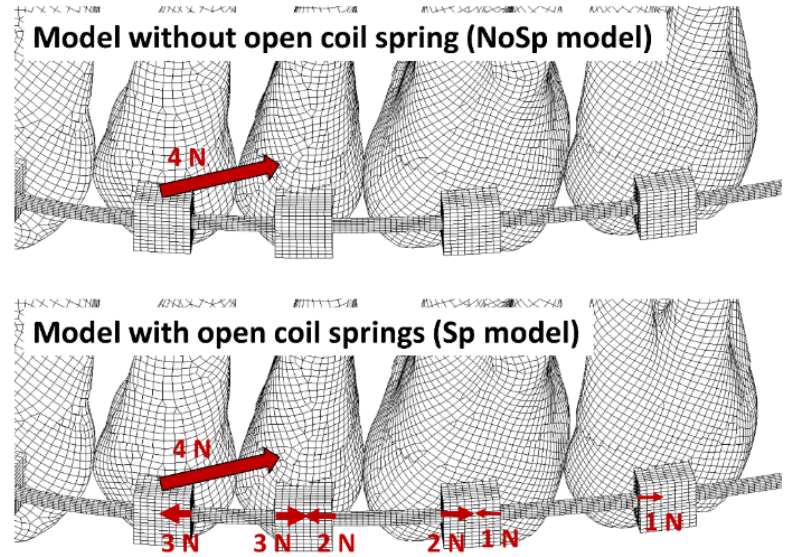
Figure 3. The two simulated force systems: the model without open-coil springs (NoSp model), and the model with three open-coil springs (Sp model), which we proposed in the present study.